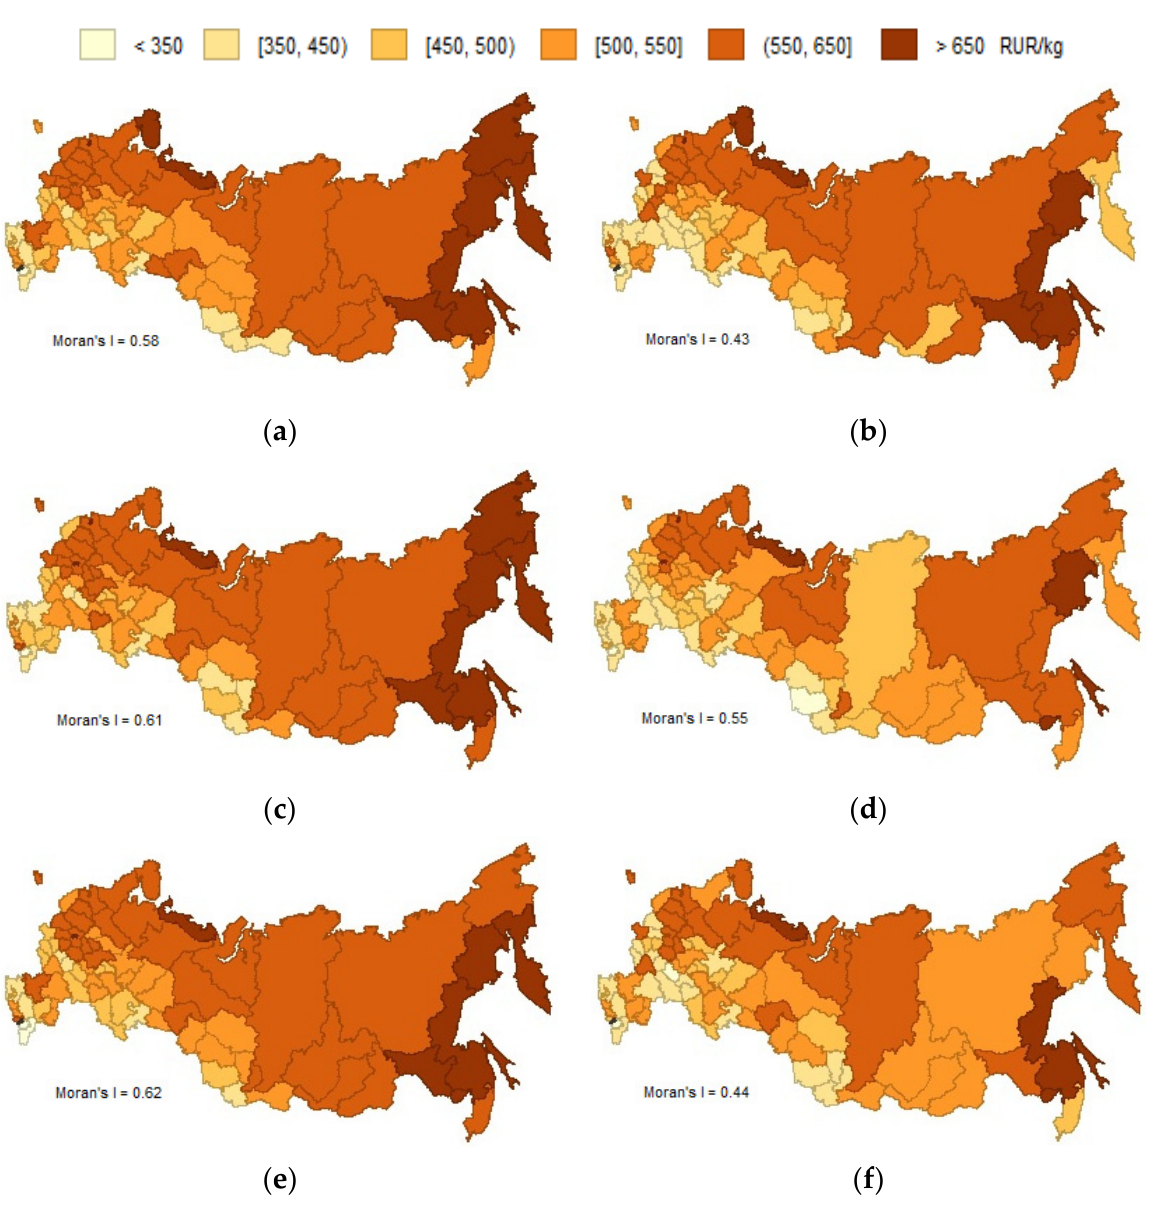
Figure 5. Spatial price of Butter on Sunday: 28 March 2021 ( a ), 11 April 2021 ( c ), 25 April 2021 ( e ), and Monday: 29 March 2021 ( b ), 12 April 2021 ( d ), 26 April 2021 ( f ). The spatial variation and spatial autocorrelation usually decrease when the prices rise because of dwindling stocks from the previous year (Figures 1, 2 and A1). At the same time, the quality/availability of warehouse storage and the volume of stocks in regions vary significantly, which results in fragmentation of the national market. In this case, the Moran’s I values drop, indicating a higher price difference between neighboring regions. The effect of the season is important, e.g., for